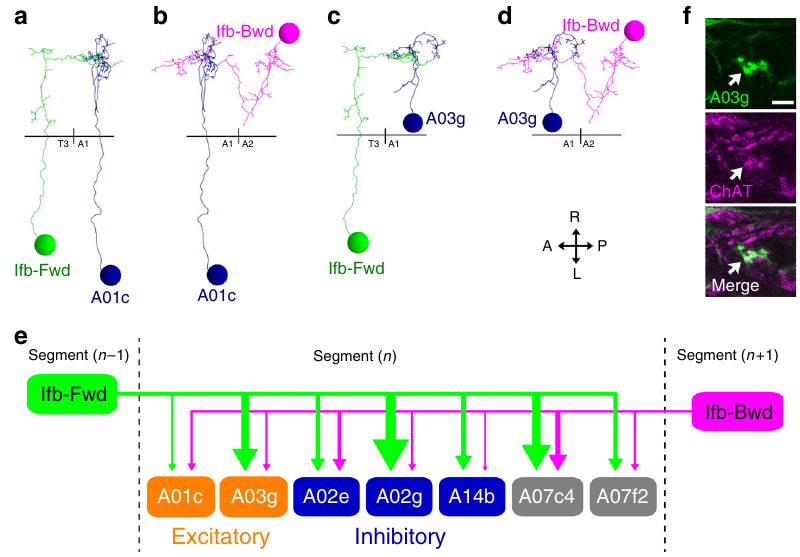
Fig. 4 Ifb-Fwd and Ifb-Bwd share postsynaptic target neurons. a – d Dorsal views of the reconstructed Ifb-Fwd and Ifb-Bwd and their postsynaptic targets A01c and A03g. Black horizontal lines indicate the midlines. e Downstream neurons shared by Ifb-Fwd and Ifb-Bwd (excitatory neurons, orange; inhibitory neurons, blue; neurotransmitter unknown, gray). We assigned their neurotransmitter phenotype as follows: A01c was reported to be cholinergic 20 . A14b is putatively GABAergic since it belongs to a lineage of GABAergic neurons 20 . A03g is shown to be cholinergic in ( f ). The neurotransmitter phenotype of the other two neurons (A07c4 and A07f2) could not be tested due to lack of speci fi c Gal4 lines. The widths of arrows indicate synapse numbers. f Dorsal view of A03g ( R36G02>mCD8::GFP ) counterstained for ChAT ( n = 5 larvae). Scale bar, 5 µ